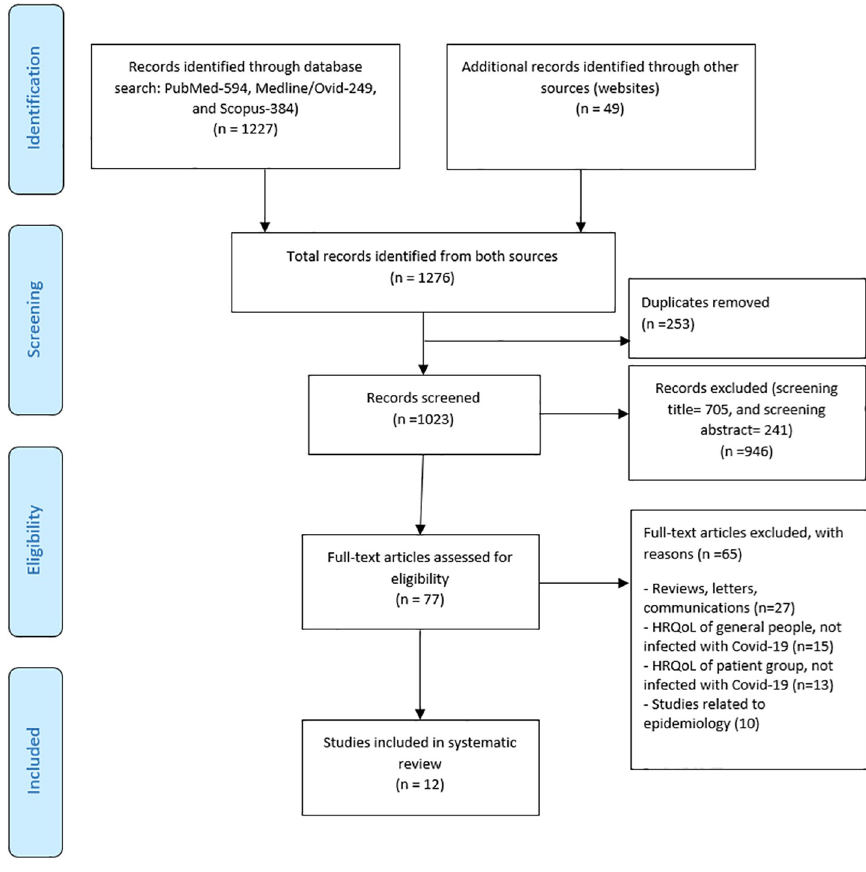
Fig 1. PRISMA 2009 flow